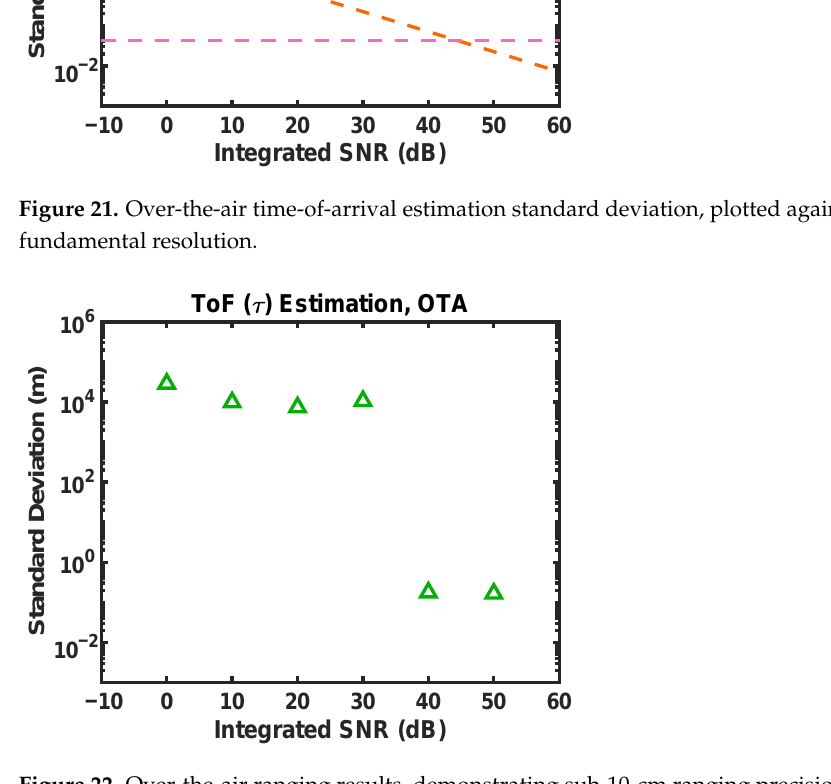
Figure 22. Over-the-air ranging results, demonstrating sub-10-cm ranging precision.